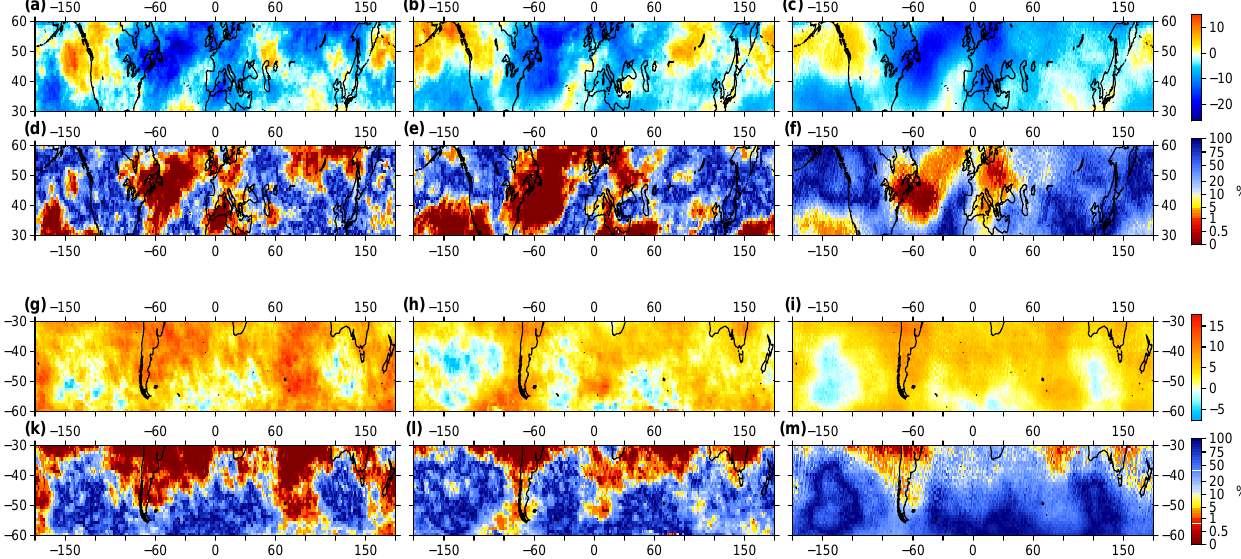
Fig. 5. Pointwise regression coefficient estimates (in DU ( unitSatoIndex ) − 1 ) for the volcanic eruption of El Chich´on on an annual basis for (a) EHOs, (b) ELOs, and (c) mean values of total ozone at 30 ◦ N to 60 ◦ N; (d) – (f) show the p -values of pointwise significance tests for the estimates in (a) – (c) . (g) – (m) as (a) – (f) but at 30 ◦ S to 60 ◦ S. An augmented version of this figure including standard errors for all coefficient estimates is provided in Fig.